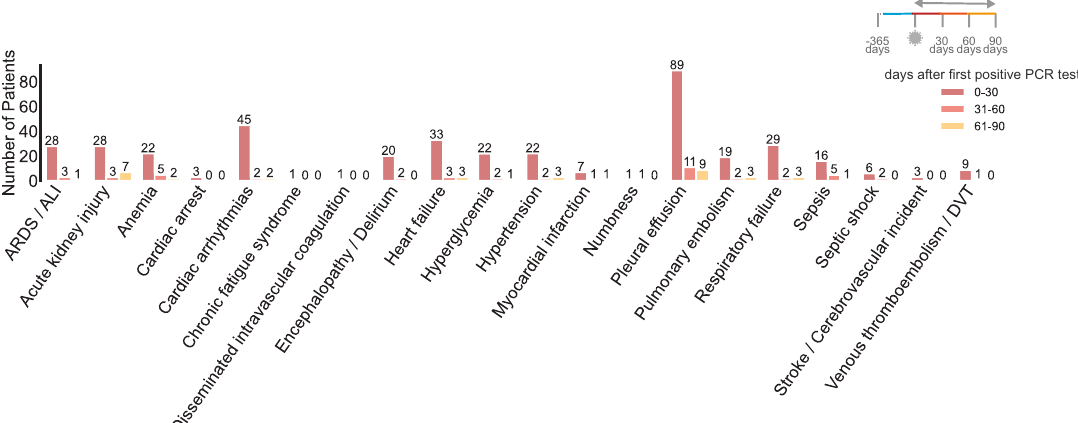
Fig. 1 Study design and overview. A Relative timeline for each of the patients in the study, divided into the pre-COVID phase (1 year prior to the fi rst positive PCR test), and the SARS-CoV-2 positive phase (90 days following the fi rst positive PCR test). B Clinical notes from 1803 hospitalized COVID and non-COVID patients are analyzed with Bidirectional Encoder Representations from Transformers (BERT) model to extract the presence or absence of comorbidities and complications. C Distribution of pre-existing conditions in the fi rst year before the fi rst positive PCR test. D Distribution of complications at early (0 – 31 days) and late time points (31 – 60 days and 61 – 90 days) after the fi rst positive PCR